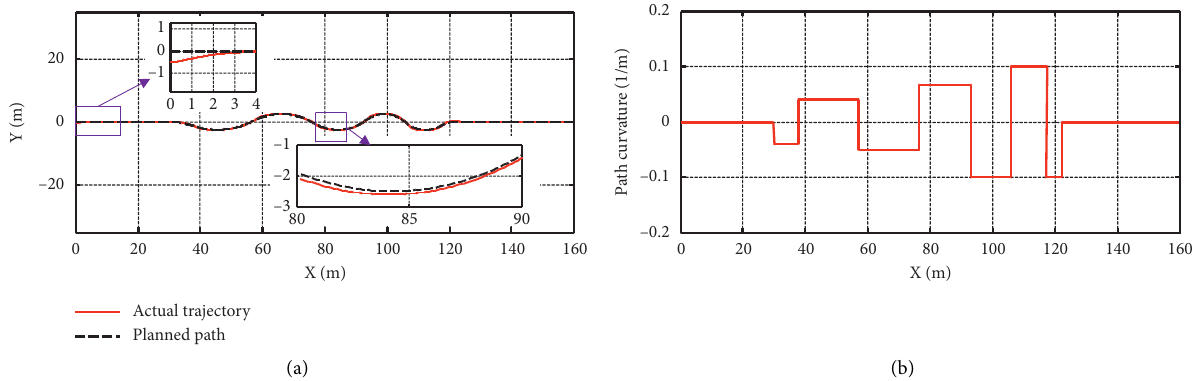
Figure 5: The trajectory of the path-following vehicle against curvature variations of the path.